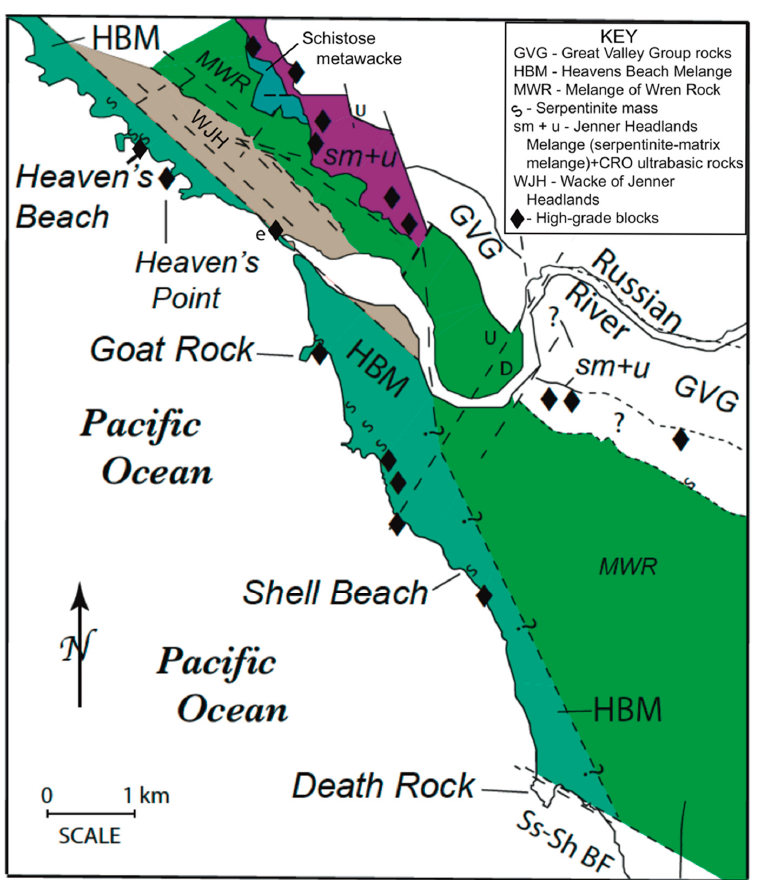
Figure 6. Simplified reconnaissance geologic map of part of the Sonoma County coast, California, showing the location of the eclogite-bearing Jenner Headlands M é lange and overlying rocks of the Coast Range Ophiolite (CRO), labeled together as sm + u, and the general extent of the Heaven’s